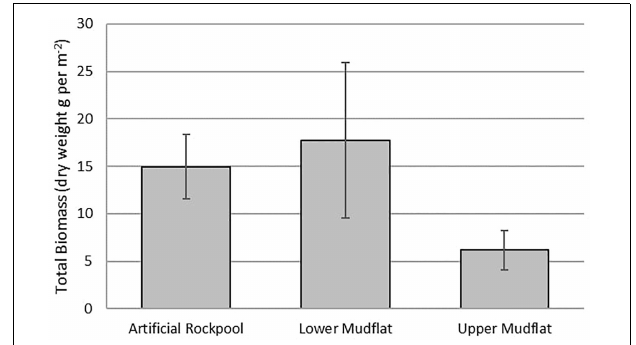
FIGURE 5 | Mean total biomass for soft-bottomed habitats. Error bars show ± Standard